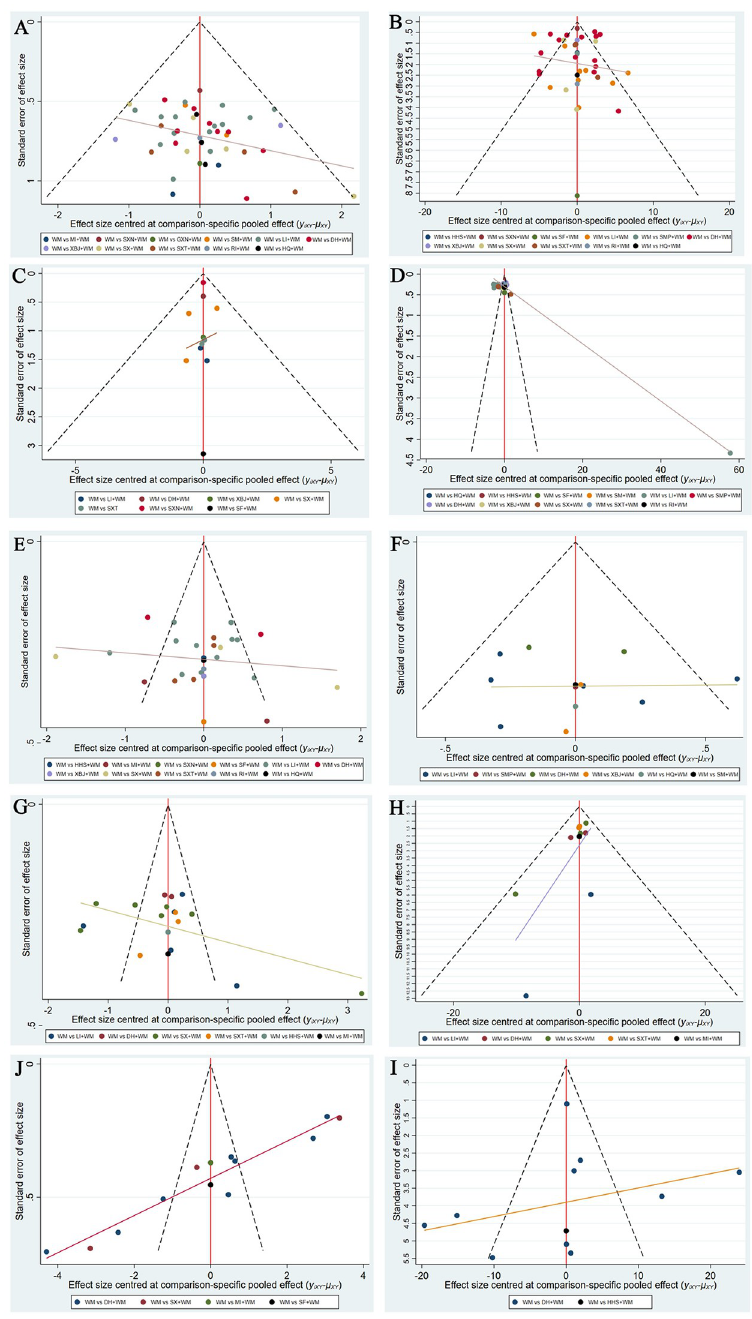
Fig 5. Funnel plots. A, CER; B, PaO2; C, PaCO2; D, DLCO; E, FVC; F, TLC; G, FEV1%; H, FEV1/FVC%; I, IIIC; J, pharmacological treatment (e.g. glucocorticoids, anti-fibrotic drugs) and non-pharmacological treatment (e.g. oxygen and ventilators). Different outcome indicators such as CER, PaO2, PacO2, pulmonary function test (DLCO, FVC, TLC, FEV1%, and FEV1/FVC%), and molecu- lar composition (IIIC and TGF)-associated fibrosis were analyzed to identify drugs with more